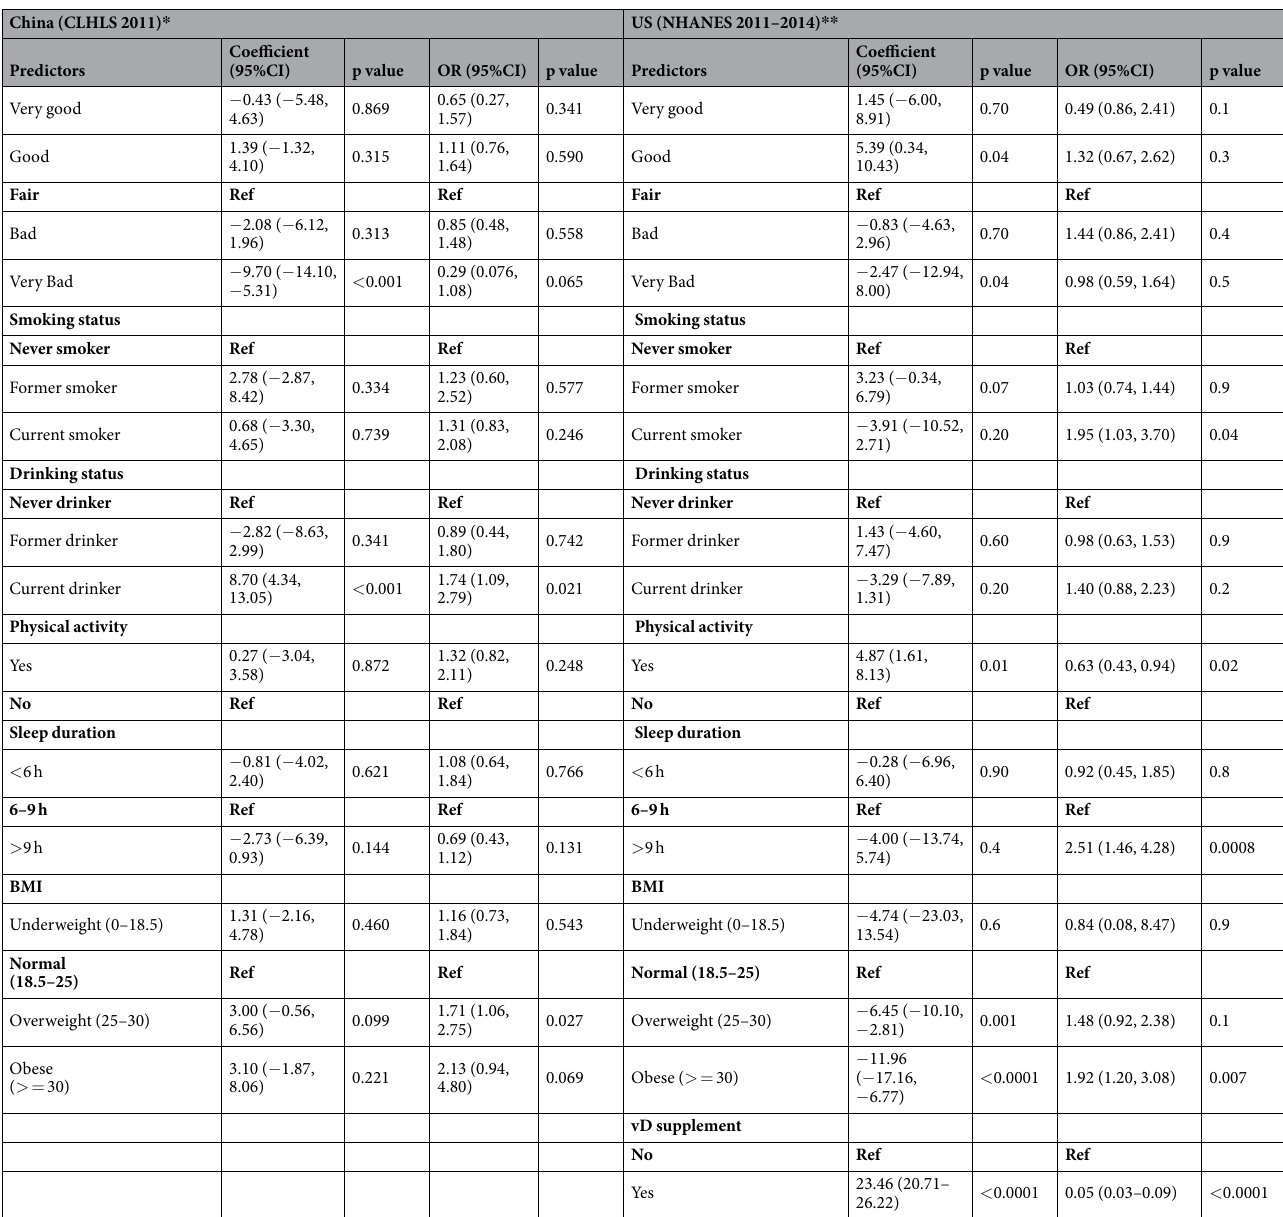
Table 3. Linear regression predicting serum 25(OH)D level and logistic regression predicting vitamin D deficiency in China and the US. * All regression models were adjusted for month of blood draw, age, gender, ethnicity, education, marital status, household income, health condition, smoking and drinking status, physical activity, sleep duration, and BMI in the CLHLS analysis. ** All regression models were adjusted for season of sampling, age, gender, season, race/ethnicity, education, marital status, income, health condition, smoking and drinking status, physical activity, sleep duration, BMI, and vD supplement in the NHANES